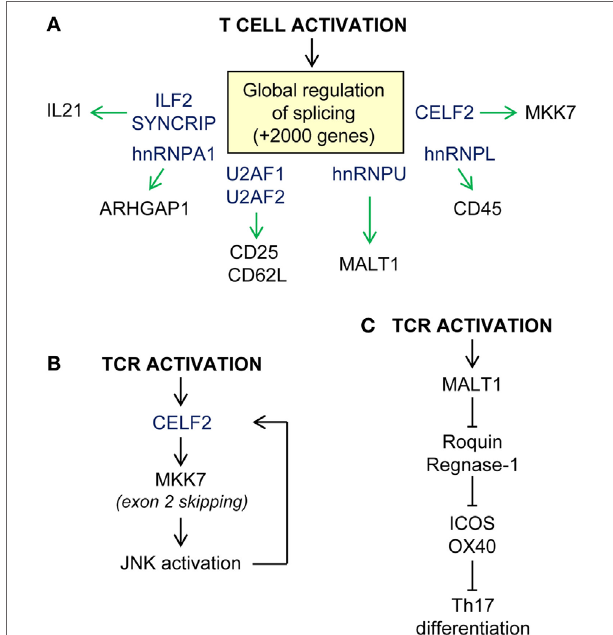
FiGURe 3 | Examples of post-transcriptional regulation upon T-cell activation. (A) Global regulation of RNA splicing upon T-cell activation. Splicing regulators (in blue) control alternative splicing and/or expression of T-cell receptor (CD25, CD62L, CD45), kinases (MKK7), paracaspases (MALT1), and cytokines (IL21) among other proteins. (B) CELF2-MKK7-JNK axis of enhanced TCR-mediated activation. (C) T-cell differentiation in modulated by the extension of MALT1 paracaspase activation, cleavage of Roquin and Regnase-1 RBP, and release repression of their mRNA